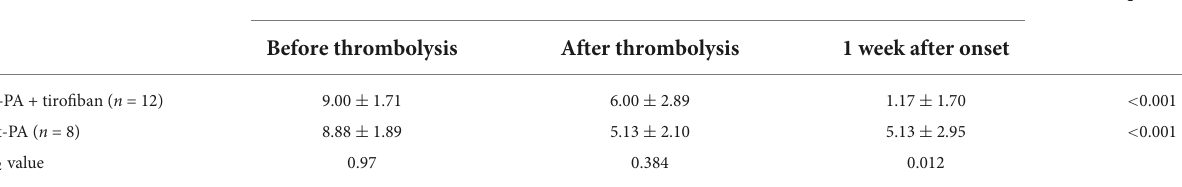
TABLE 2 Comparison of National Institutes of Health Stroke Scale (NIHSS) score between recombinant tissue plasminogen activator (rt-PA) treatment and recombinant tissue plasminogen activator (rt-PA) combined with tirofiban groups. Variable